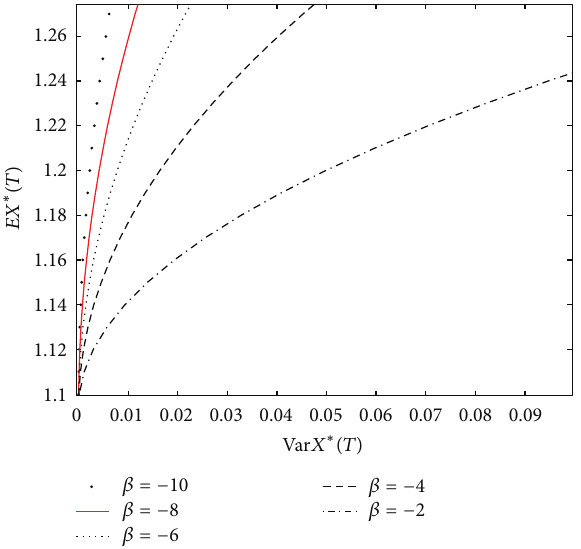
Figure 5: The efficient frontiers in mean-variance plane ( 𝛽 = −1.0, . .. ,−0.2 ).